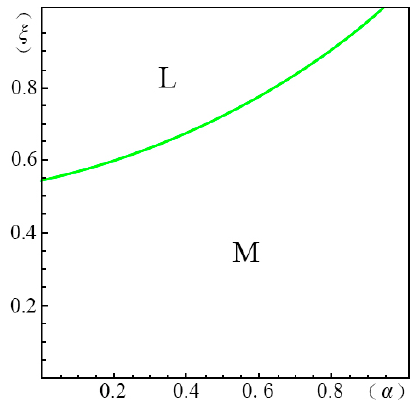
+ kg − p (cid:3397)(cid:1863)(cid:1859) (cid:2879)(cid:3043) σδ Q − 1 (cid:3097)(cid:3083)(cid:3018)(cid:2879)(cid:2869)